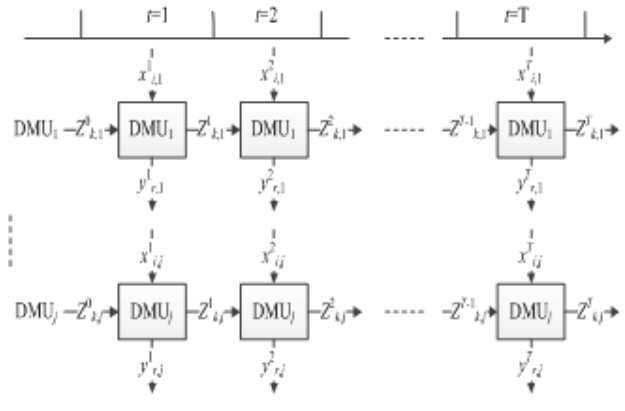
Figure 1. The flow figure of the dynamic evaluation of DMU